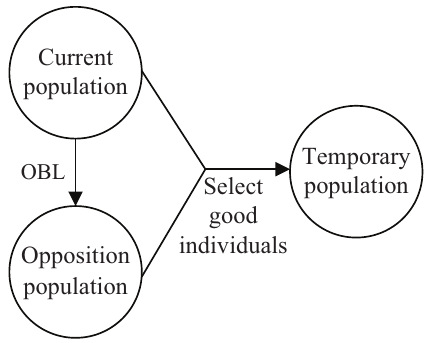
Figure 6. General dynamic opposition-based learning